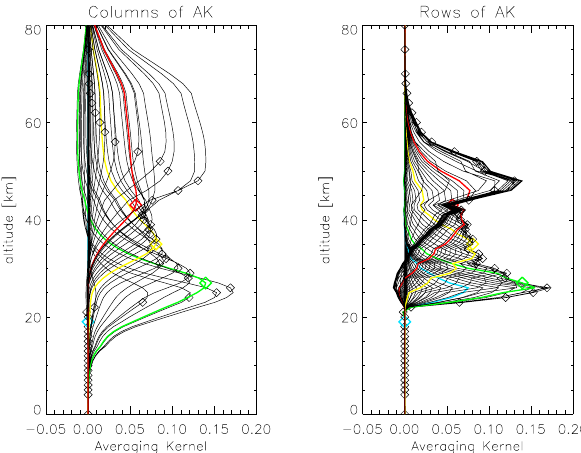
Fig. 5. Error analysis of hydrogen peroxide retrieval (orbit 7791, 27 August 2003, tropics). Error sources from top to bottom: total er- ror (solid line), noise error (dotted line) (mostly overlapped by total error), total parameter error (dashed line) containing errors due to vmr uncertainties of other gases: H 2 O, N 2 O, CH 4 , HNO 3 , CF 4 and ClONO 2 , error due to temperature uncertainty and uncertainty of the temperature gradient, line-of-sight (LOS) uncertainty, spectral shift uncertainty, gain calibration uncertainty, and residual uncer- tainty of the instrumental line shape (ILS).